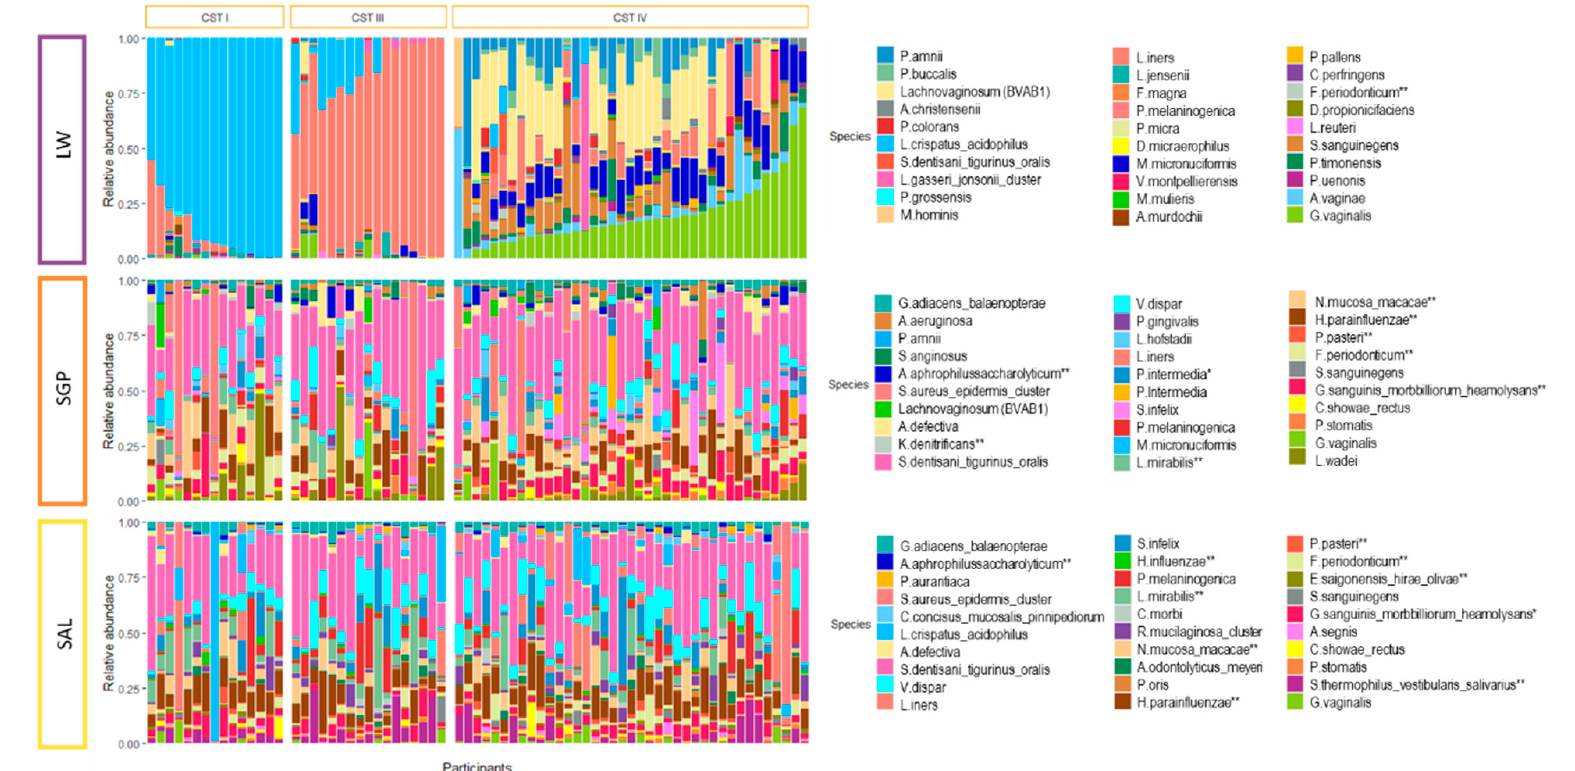
Figure 2. Microbial communities in the vagina, saliva and supragingival space. Bar plot depicting the relative abundance of the 30 most abundant bacterial species for each site in matched vaginal (LW, top), supragingival (SGP, middle) and salivary (SAL, bottom) samples identified by 16S rRNA microbiome profiling. The samples are aligned by PID (N = 72) and grouped by vaginal community state type (CST) (CST-I, CST-III, CST-IV) established using soft k-means clustering with weighted-UniFrac distances and ordered based on the abundance of the most dominant species in each CST (CST-I: L. crispatus , CST-III: L. iners and CST-IV: G. vaginalis ). The species richness of the SAL microbiota was higher in BV positive compared to BV negative